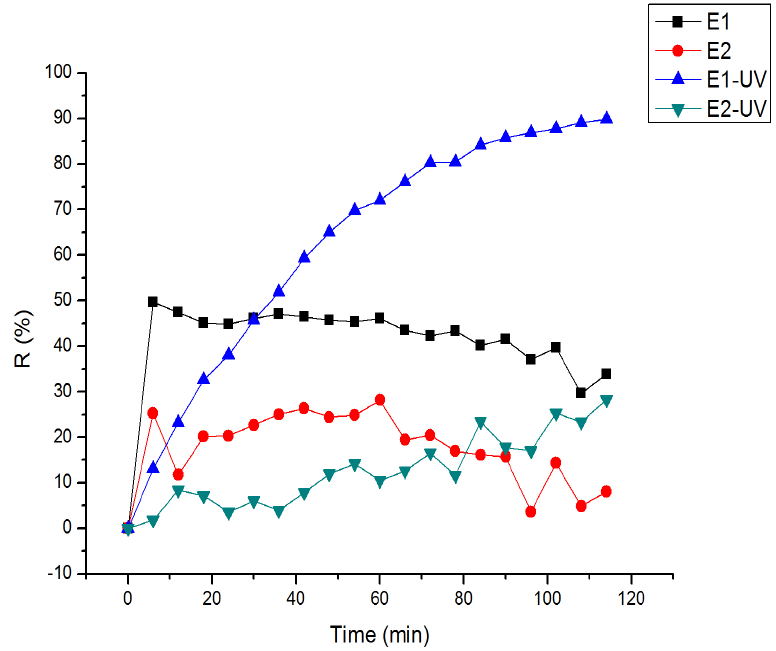
Figure 5. Removal efficiencies of E1 and E2 using a PVDF-PVP ultrafiltration membrane.